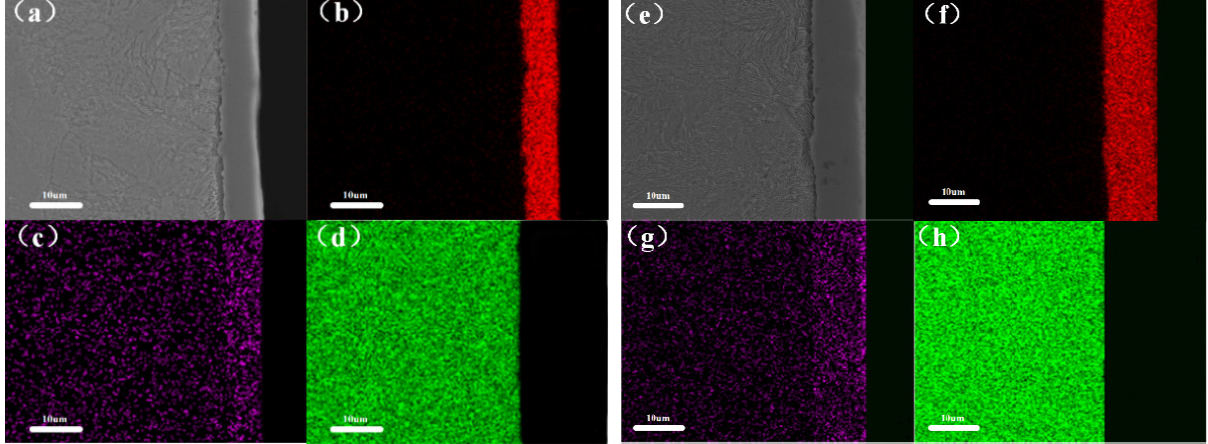
Figure 4. SEM morphology and EDS analysis of the vanadiumizing layer. ( a , e ) SEM image of vanadiumizing layer; ( b , f ) distribution of vanadium element; ( c , g ) distribution of carbon element; ( d , h ) distribution of iron element.